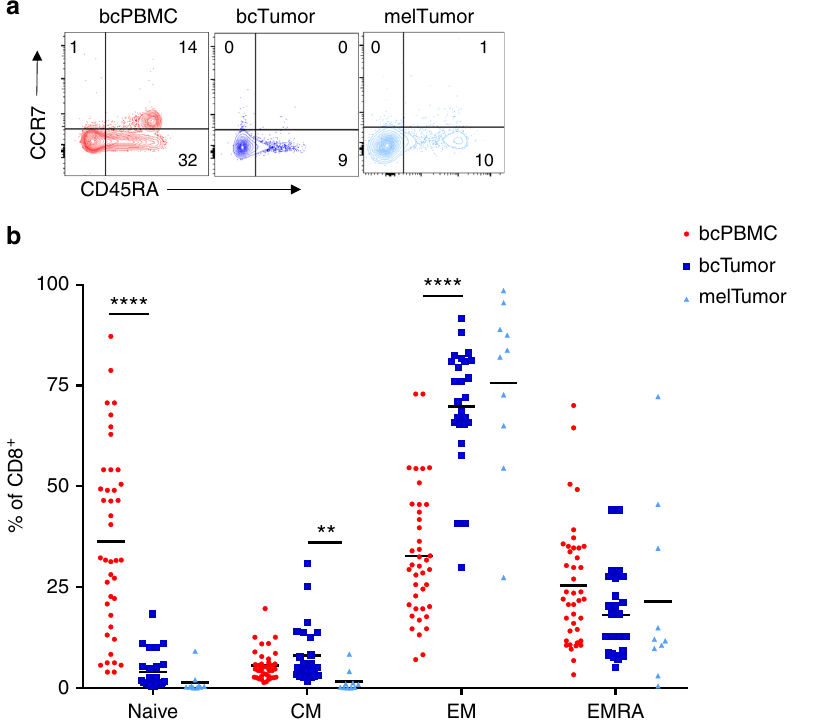
Fig. 1 CD8 + TILs in breast tumors are predominantly effector memory cells. a Memory phenotypes of CD8 + T cells in patient peripheral blood mononuclear cells (bcPBMCs), breast cancer patient primary tumors (bcTumor), and melanoma patient tumors (melTumor) were phenotypically characterized by fl ow cytometry. Representative contour plots show cell population gates for naive (CCR7 + CD45RA + ), central memory (CM, CCR7 + CD45RA − ), effector memory (EM, CCR7 − CD45RA − ), or effector memory RA + (EMRA, CCR7 − CD45RA + ). b Graph depicts percentage of naive, CM, EM, and EMRA among CD8 + T cells in bcPBMCs, bcTumor and melTumor. Each symbol represents data from a unique patient sample. Signi fi cance was calculated using one-way ANOVA and Holm – Sidak multiple comparison tests; ** p < 0.01; **** p <